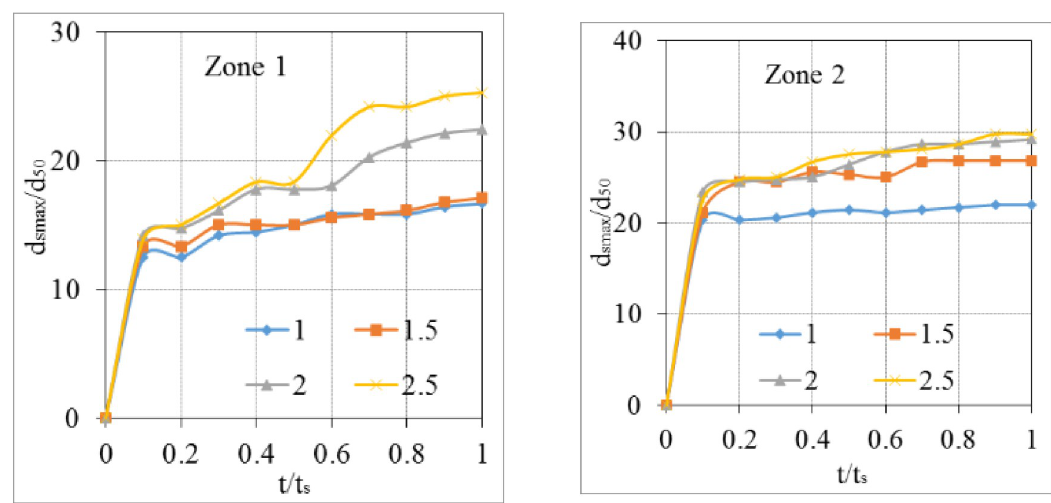
Fig 10. The effect of c on morphological change rate at the outlet of the culvert (Zone 1) and meander segment (Zone 2). s